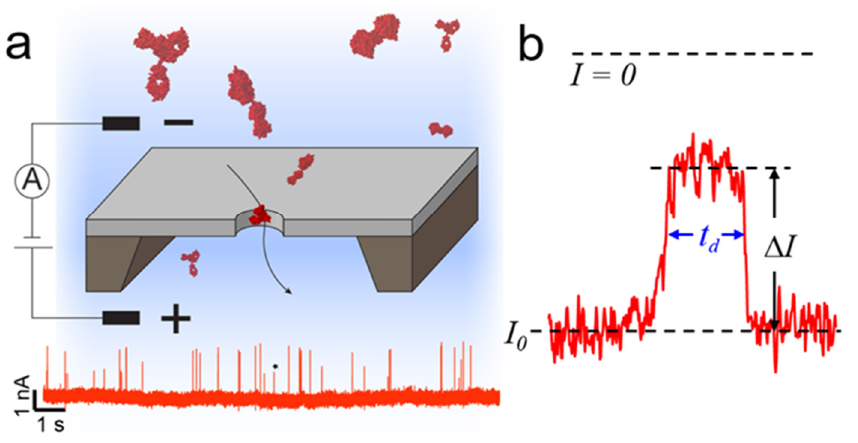
Figure 1. Single molecule detection by a synthetic nanopore. ( a ) Illustration of the concept of nanopore sensing. An electrical potential applied across a nanoscale pore creates a constant ionic current, and proteins passing through the sensing volume (indicated by the black arrow) produce resistive pulses. The red trace represents a typical measured current trace over time. Each spike represents a translocation of a protein through a nanopore. ( b ). Expanded trace (marked by * in panel ( a )) representing a single protein translocating though a nanopore. The amplitude of current change, Δ I , is proportional to particle volume and the dwell time, t d , correlates to the particle charge and diffusion coefficient.